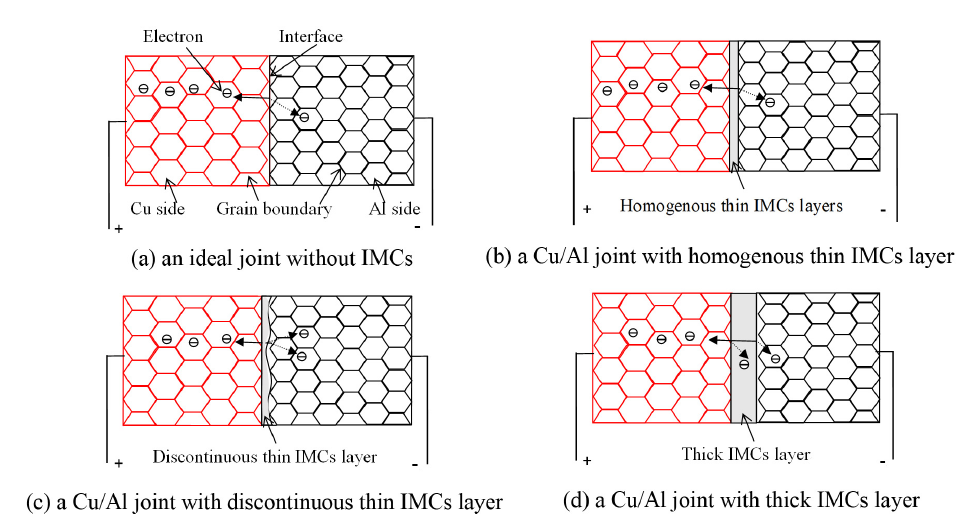
Figure 12. Model of electron motion across the interface of Cu/Al with and without IMCs layer: (a) an ideal joint without IMCs; (b) a Cu/ Al joint with homogenous thin IMCs layer; (c) a Cu/Al joint with discontinuous thin IMCs layer; (d) a Cu/Al joint with thick IMCs